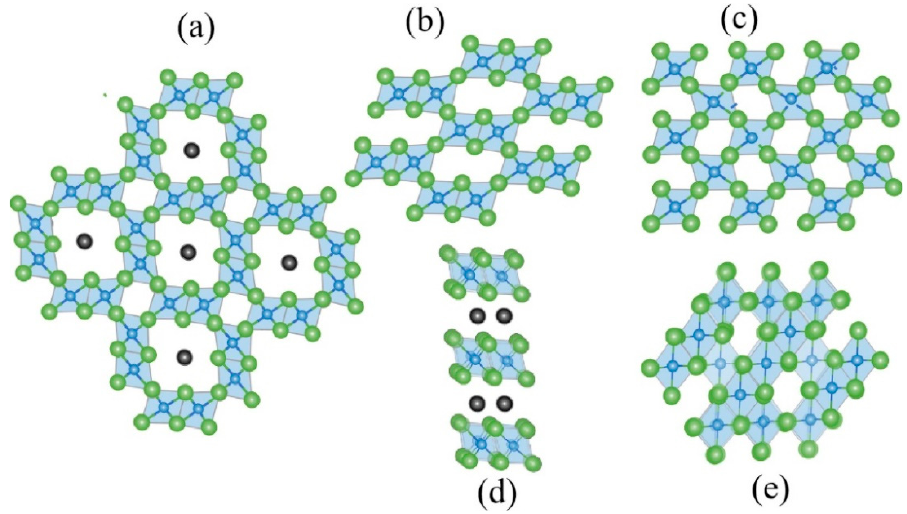
Figure 2. Five crystal structures of MnO 2 ( δ -, γ -, α -, β - and λ -MnO 2 ): ( a ) α -MnO 2 , ( b ) γ -MnO 2 , ( c ) β -